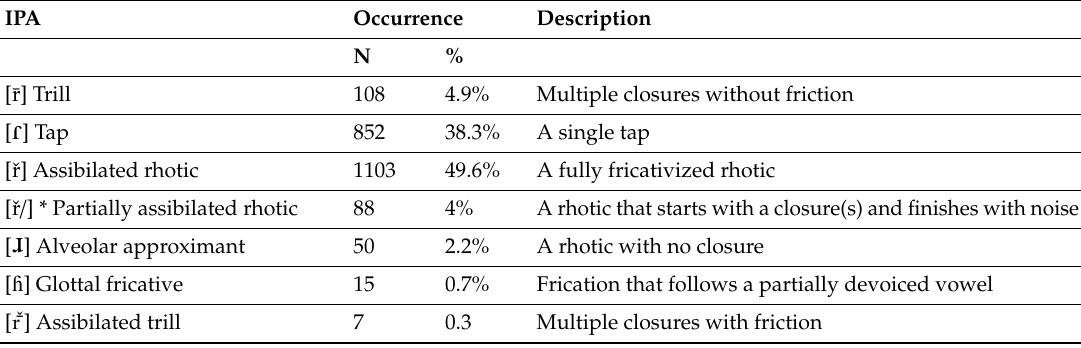
Table 2. Frequency of occurrence of all rhotic variants (three tasks combined).